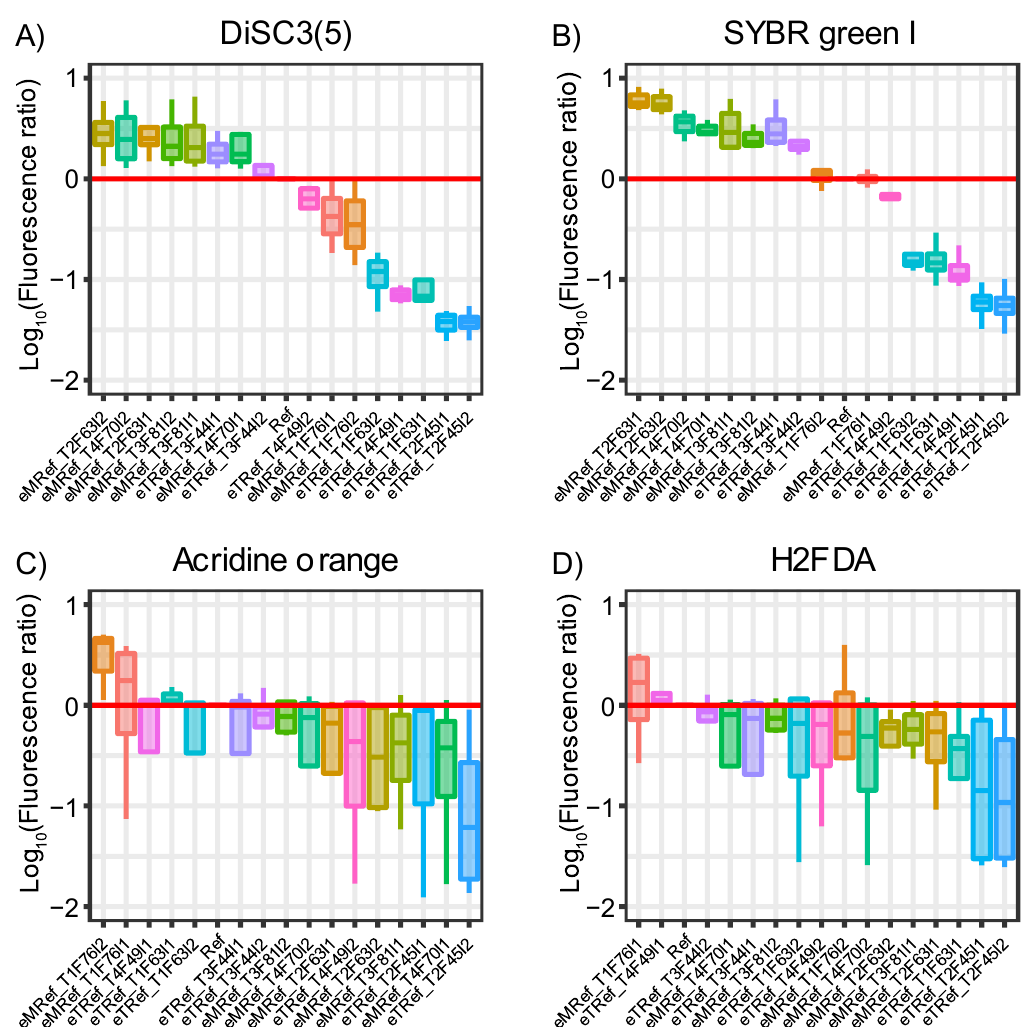
Figure 7. Intracellular levels of fluorophores in the evolved strains eTRef and eMRef in comparison to the parental strain ‘ Ref ’. The accumulation of these 4 fluorophores was depicted as the ratio of the median fluorescence signals for 16 different clonal isolates (abscissa) against that of the ‘ Ref ’. The data was log-transformed. Thus, a unit difference in the ordinate corresponds to a ten-fold difference. The red line indicates no difference observed. The data distribution and median of at least four biological replicates are represented in each box plot. ( A ) DiSC3(5), ( B ) SYBR green I, ( C ) Acridine orange, and ( D ) H2FDA. Names of the clonal isolates were abbreviated based on each TALE lineage identifier, flask number from which evolved clones were derived, and the isolate number (TALE 1 to TALE 4: T1 to T4, Flask number: F#, and Isolate 1 and Isolate 2: I1 and